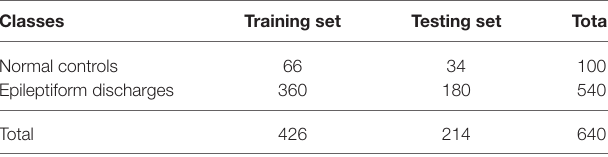
TABLE 1 | Class distribution of the samples in the training and testing data